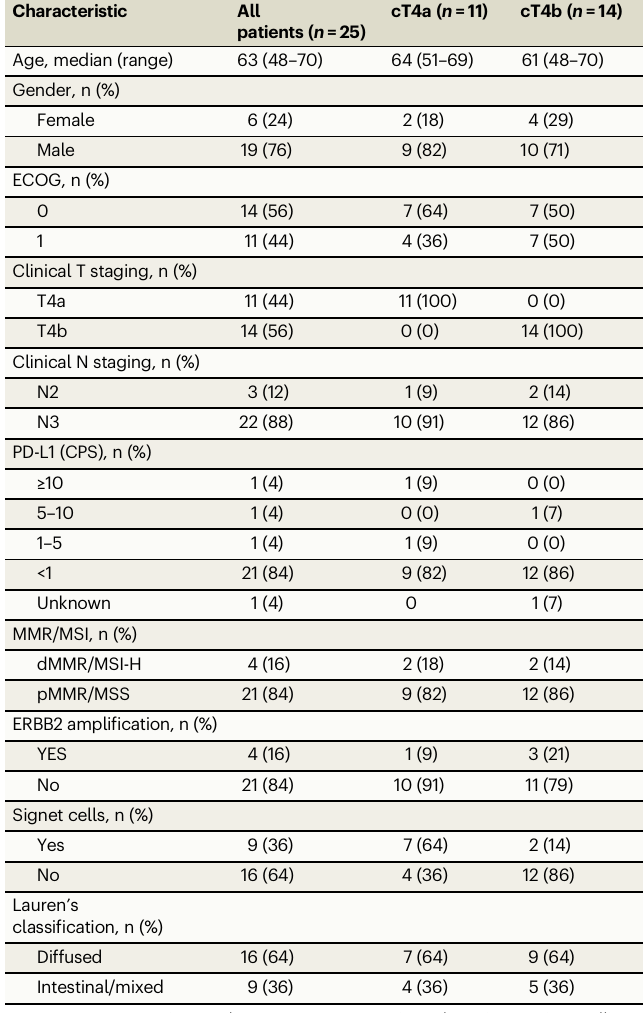
Table 1 | Baseline characteristics of patients according to clinical T staging